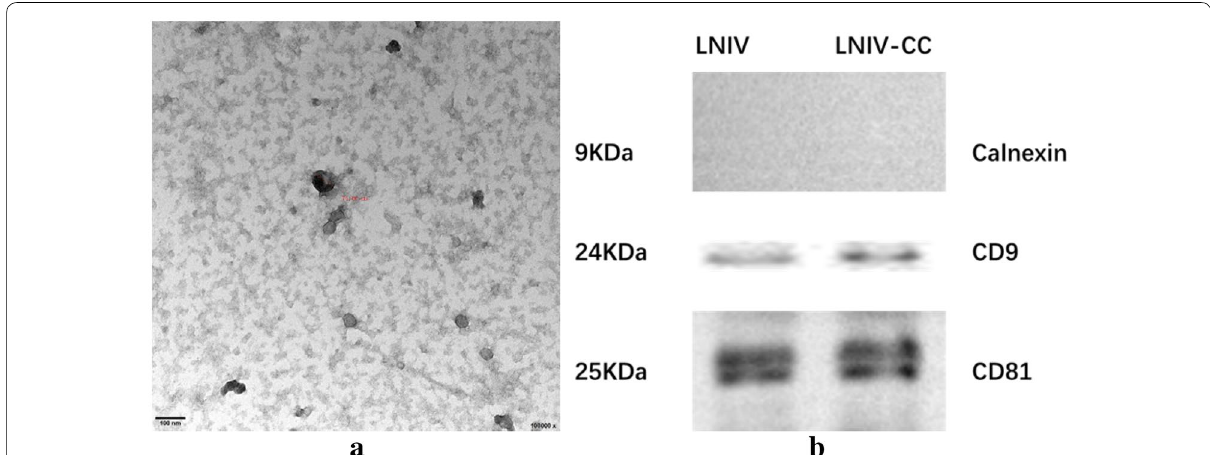
Fig. 1 Characteristics of urinary exosomes. a Transmission electron microscope images of isolated exosomes. Bars exosome measured at 74.66 nm. b Western blot indicated CD9 and CD81-positive expression and calnexin-negative